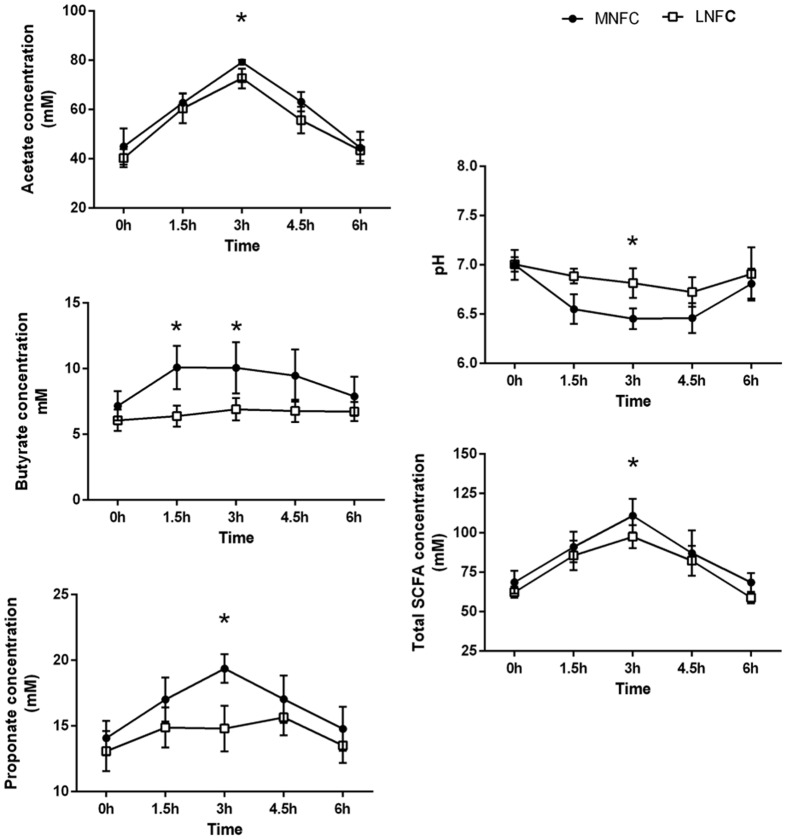
Effect of diet switch on the concentrations of short-chain fatty acids (SCFAs; acetate, propionate, and butyrate), their molar proportions, total SCFA concentration, and the pH in the ruminal fluid of goats. 0 indicates the sampling time just before matinal feeding, and other numbers indicate the sampling time after matinal feeding. “∗” indicates a p-value < 0.05 in the t- test.